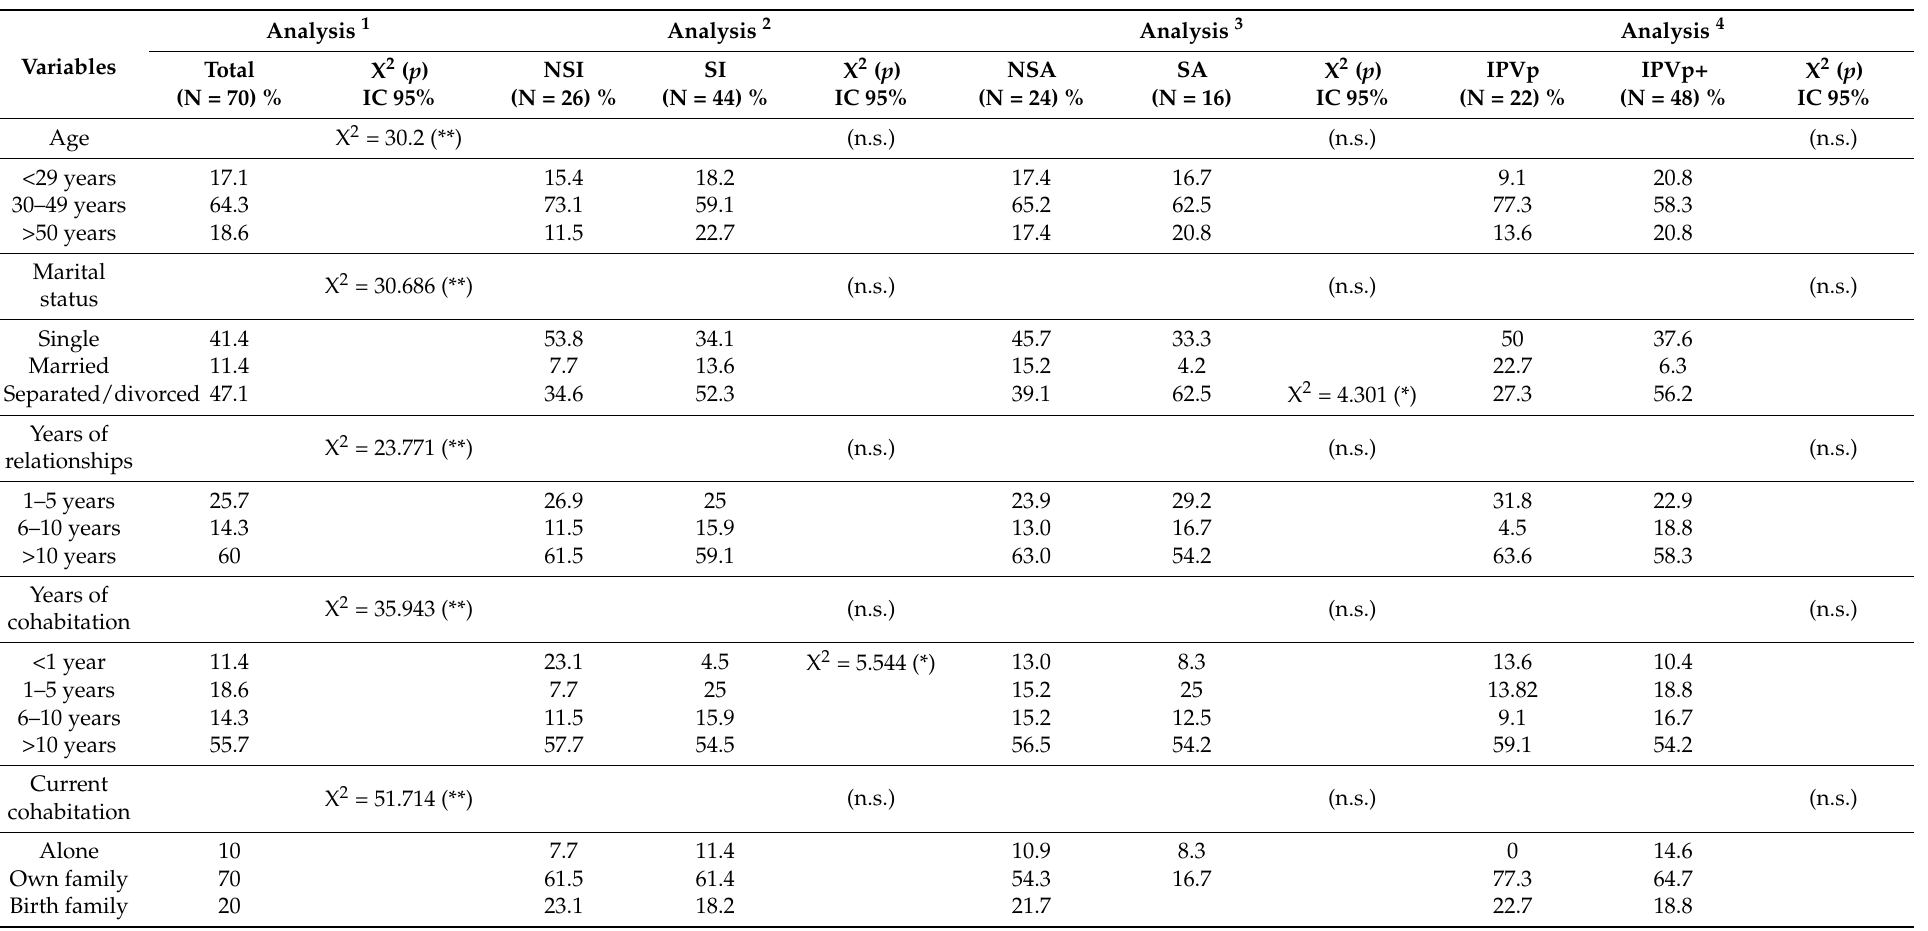
Table 1. Descriptive analysis of the